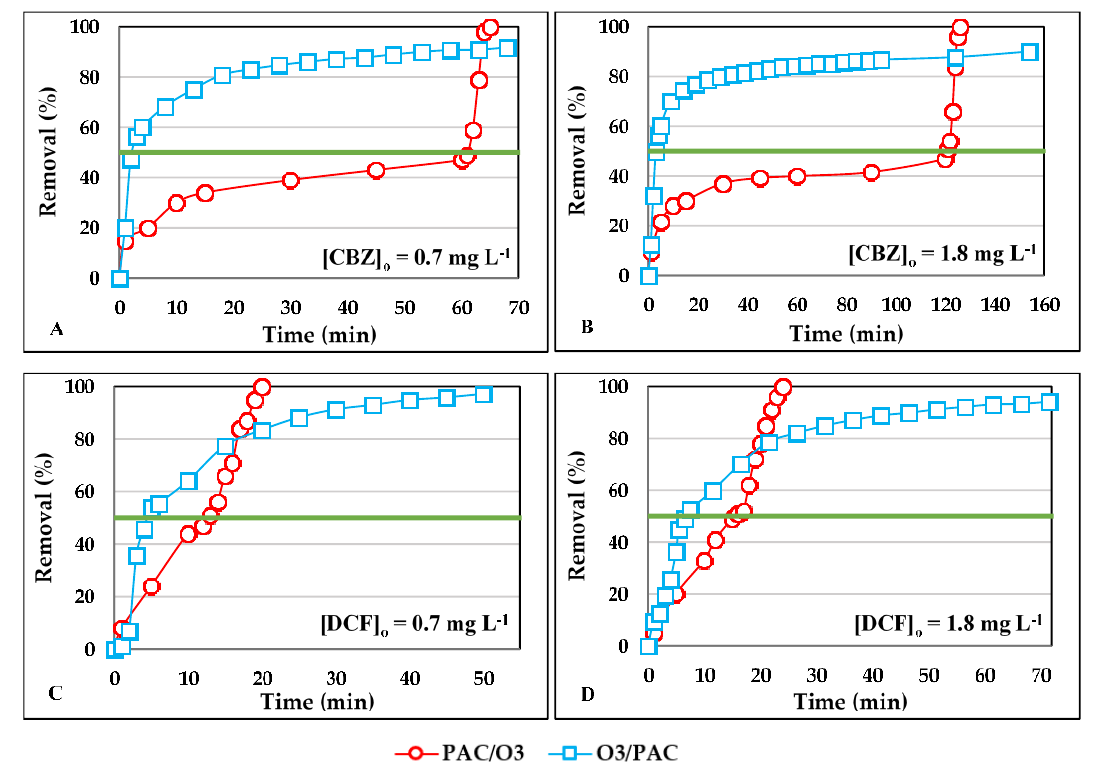
Figure 4. Removal percentages of CBZ and DCF over time for combined treatments O 3 /PAC and PAC/O 3 . PAC doses = 16 mg L − 1 and O 3 doses = 0.224 mg L − 1 : ( A ) [CBZ] 0 = 0.7 mg L − 1 ; ( B ) [CBZ] 0 = 1.8 mg L − 1 ; ( C ) [DCF] 0 = 0.7 mg L − 1 ; ( D ) [DCF] 0 = 1.8 mg L − 1 .